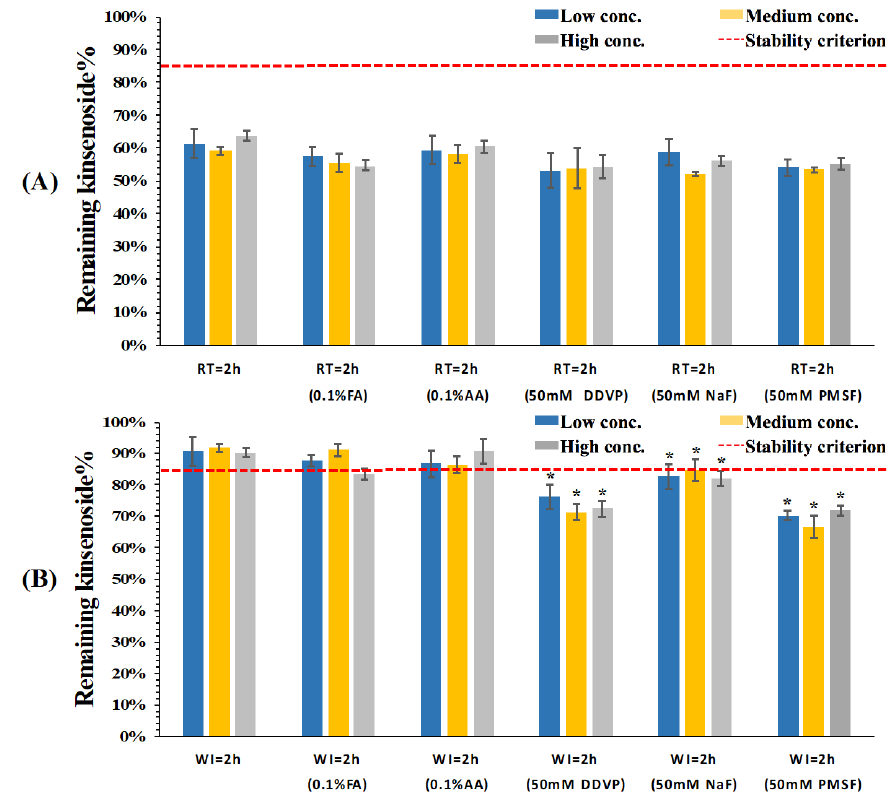
Figure 2. Remaining percentage of kinsenoside in fresh beagle dog whole blood after 2 h incubation under ( A ) room temperature and ( B ) wet ice conditions ( n = 3). The red dash lines indicate the stability criterion (85% of the nominal analyte concentrations). FA: formic acid; AA: acetic acid; DDVP: 2,2-Dichlorovinyl dimethyl phosphate; NaF: sodium fluoride; PMSF: phenylmethanesulfonyl fluoride. * p < 0.05 compared with whole blood samples incubated on wet ice after 2 h.